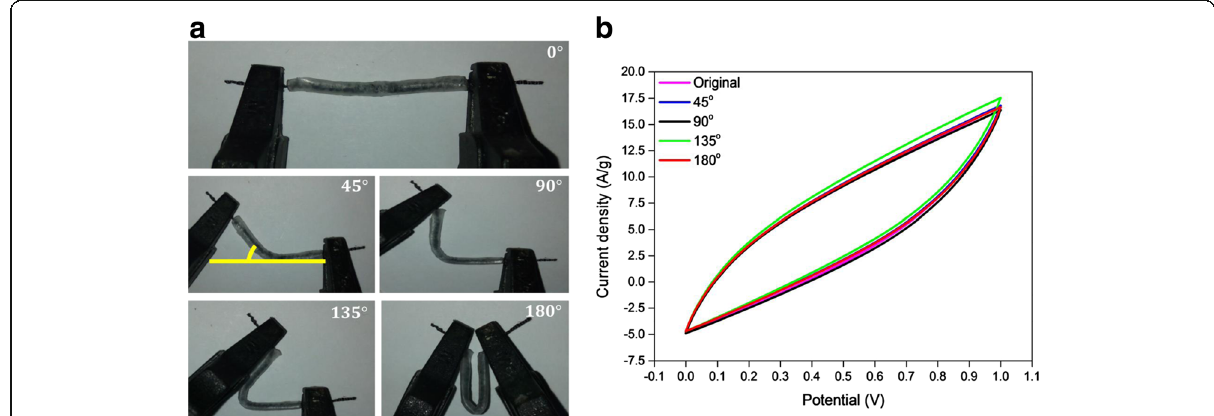
Fig. 6 a Images of flexible supercapacitor device and b CV curves of CBF/PPy-rGO-2 supercapacitor devices bent at various angles at a scan rate of 100 mV s −